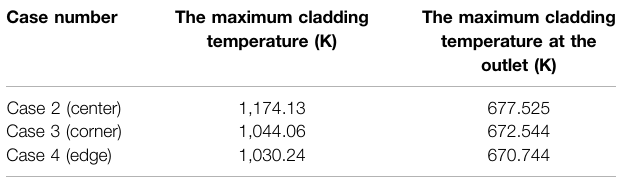
TABLE 5| Thelocal peak cladding temperature and maximum temperature at the